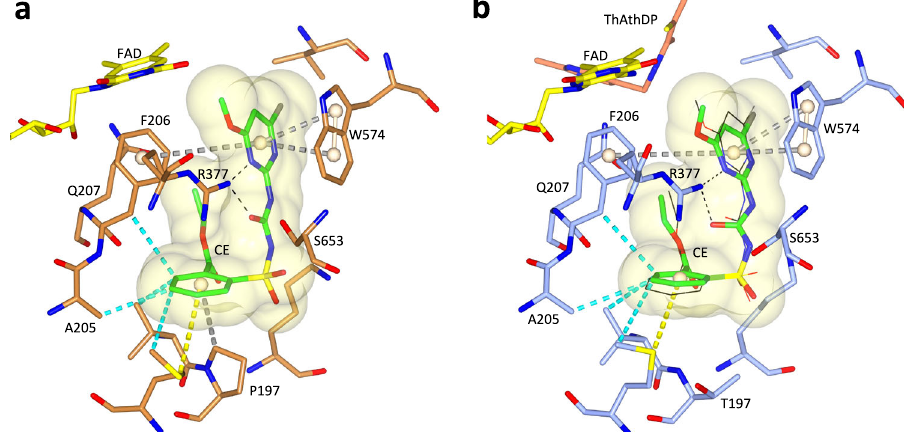
Fig. 7 The binding mode of CE in WT At AHAS and in the P197T mutant. a The interactions of CE with WT At AHAS (PDB code: 5K3S 13 ). b The interactions of CE with the P197T mutant. ThDP is degraded to ThAThDP (light brown). The black thin lines represent CE from the WT At AHAS:CE structure that has been superimposed with the P197T-CE structure. ( a , b ) CE is in green and in ball and stick representation. The FAD is in yellow and in stick representation. Dashed lines represent hydrogen bonds (black). Grey dashed cylinders represent π – π interactions. Yellow dashed cylinders represent sulfur – π interactions. Blue dashed cylinders represent hydrophobic interactions. Pale brown spheres represent the geometric centers of the aromatic groups.